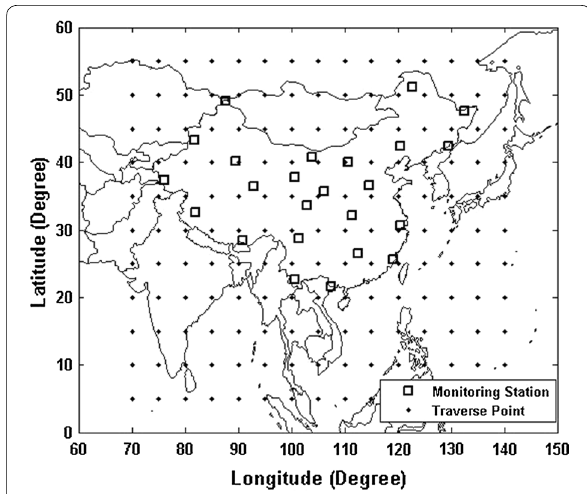
Fig. 2 Distribution of monitoring stations and traverse points